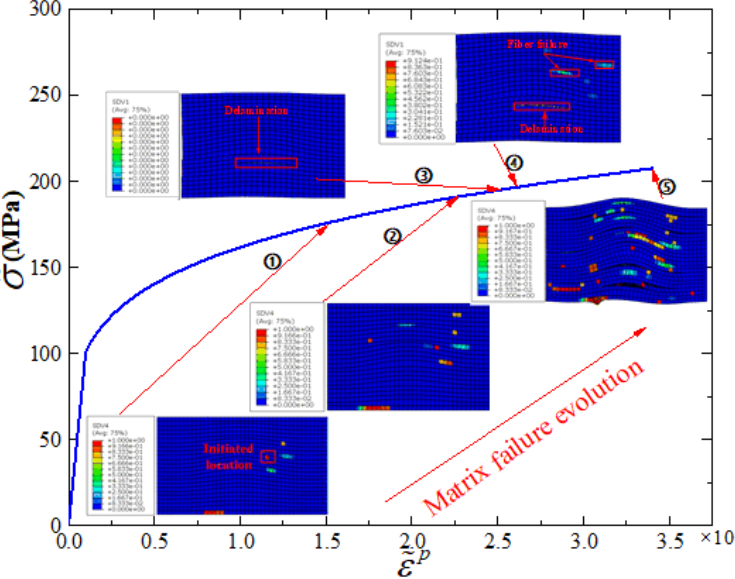
Figure 19. Equivalent stress versus equivalent plastic strain for wrinkle levels 5.6° and 11.4° .